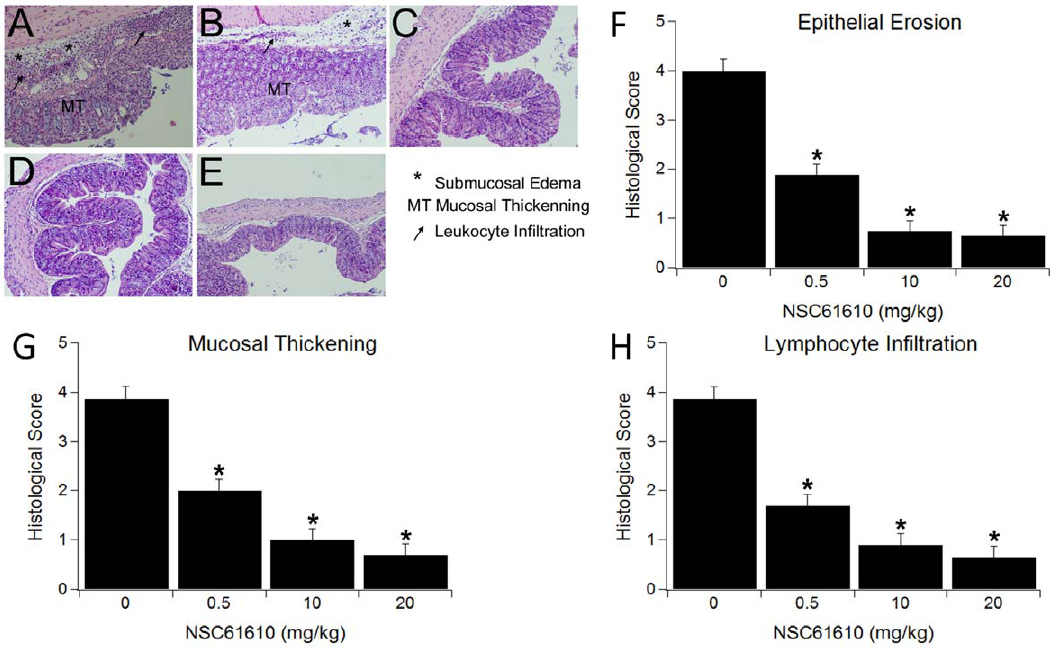
Figure 4. Oral treatment with NSC61610 ameliorates inflammatory lesions in mice with inflammatory bowel disease. Mice were challenged with 2.5% dextran sodium sulfate in the drinking water for 7 days. Representative photomicrographs from the control (A–B) and NSC61610 treatment (C–E) groups are illustrated. Colonic specimens underwent blinded histological examination and were scored based on epithelial erosion (F), mucosal wall thickening (G), and leukocyte infiltration (H). Data are represented as mean 6 standard error (n=10). Bars with an asterisk indicate that a treatment is significantly different from its control ( P , 0.05 ).